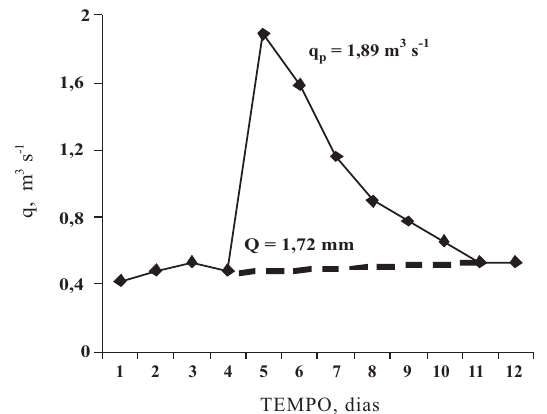
Figura 3. Exemplo de hidrograma da série de vazões observadas da bacia do Pipiripau, usado para calibração de CN (a linha tracejada é o escoamento de